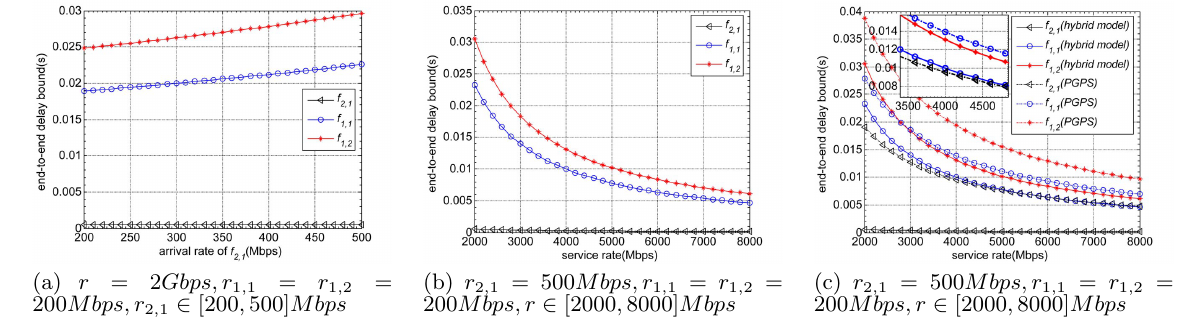
Figure 4: Delay upper bounds in the single-hop case.